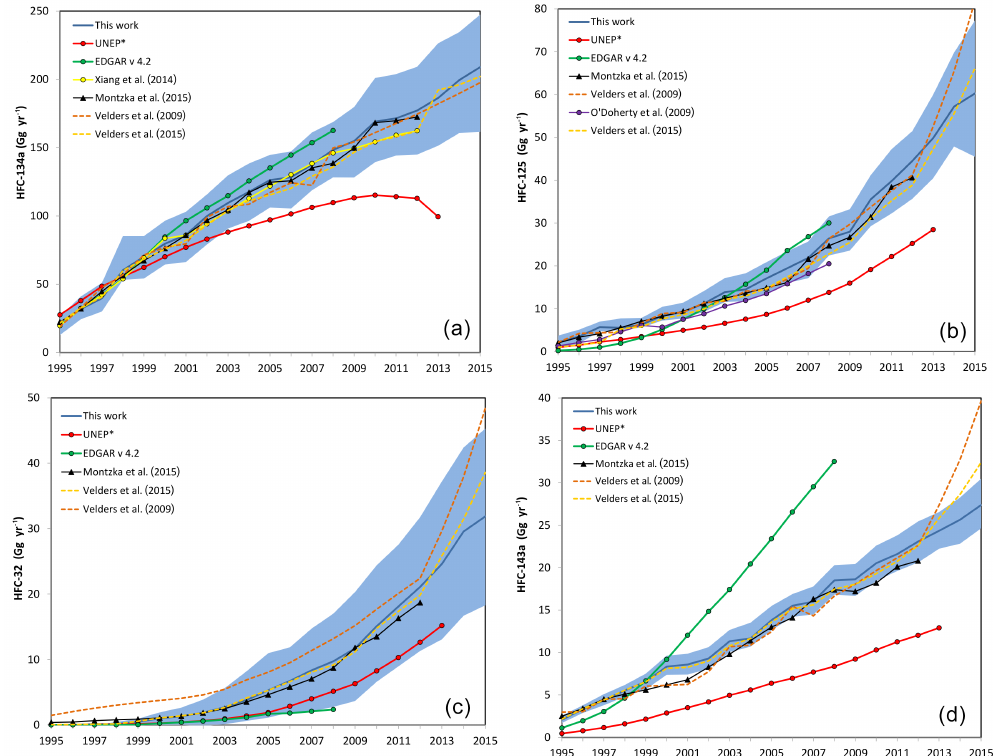
Figure 4. Global HFC emissions (Ggyr − 1 ) from the 12-box model (solid blue line); shading represents 1 σ uncertainties. UNFCCC ∗ values are the aggregates of national data reported to UNFCCC (2016). Note that for HFC-143a and HFC-32 we only use Medusa data for these calculations; for all others we use combined GC-MS-ADS and GC-MS-Medusa data.